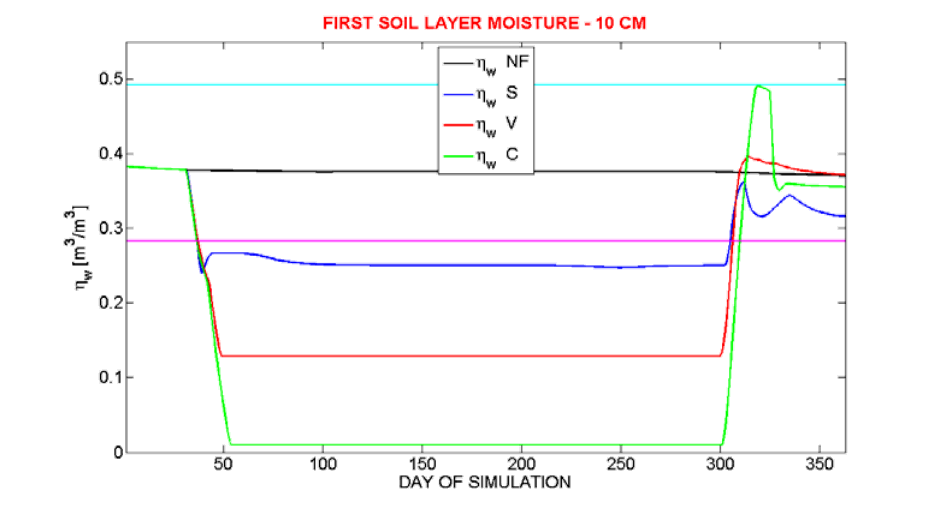
Figure 5. Simulated soil moisture in the 10 cm soil layer. The cyan line is the porosity η the pink line is the wilting point η